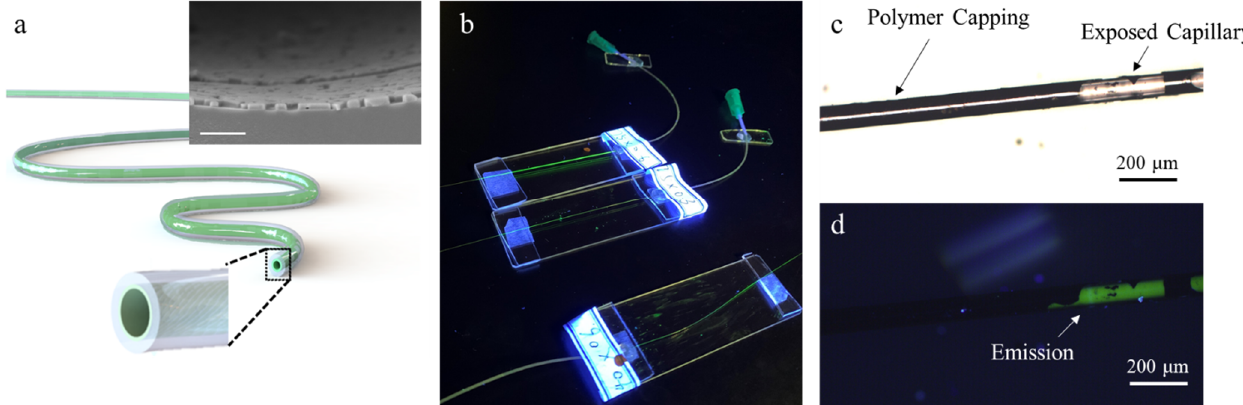
Figure 1. Luminescent perovskite micro-fluid. ( a ) A schematic diagram of the presented luminescent flexible capillary with inner surface coating. The inset shows compact and uniform perovskite assembly on the inner surface. Scale bar: 2 μm. ( b ) The experiment setup. Microscope image of the luminescent capillary under ( c ) white light and ( d ) UV lamp illumination, respectively.